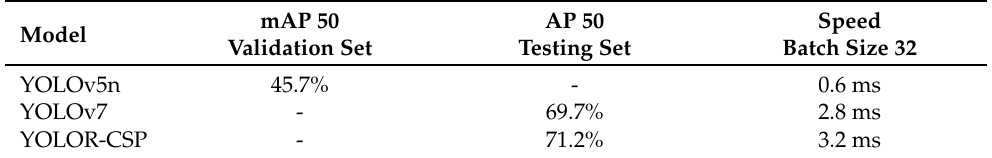
Table 8. Performance of YOLO